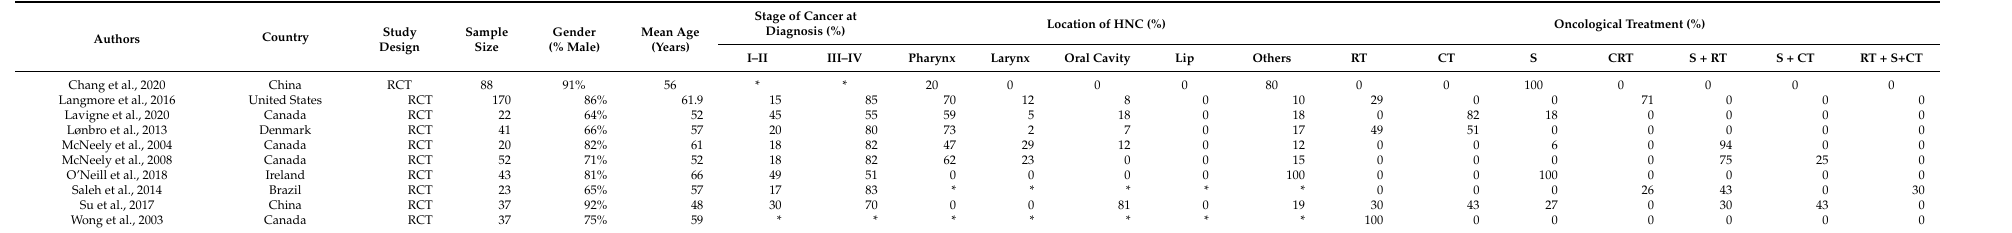
Table 1. Descriptive Synthesis of the included studies.